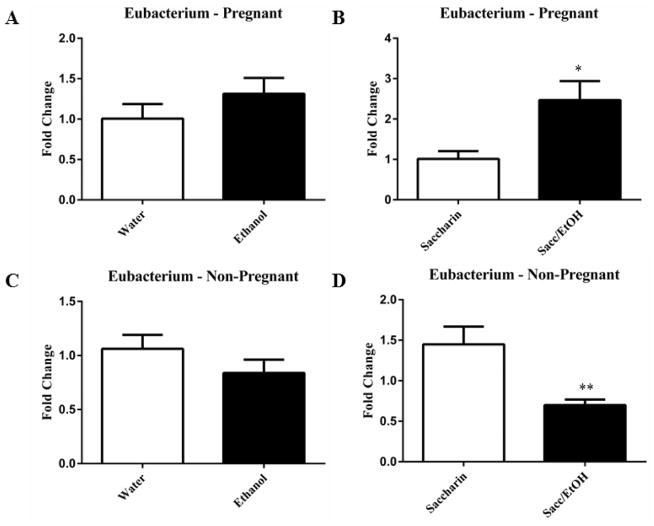
Drinking ethanol and saccharin together elevated levels of Eubacterium in pregnant mice but decreased it in non-pregnant miceEthanol in water solutions did not affect the levels of Eubacterium in either pregnant (2A) or non-pregnant animals (2C). Ethanol and saccharin in water solutions significantly increased Eubacterium levels in pregnant animals (2B) and significantly decreased Eubacterium levels in non-pregnant (2D) animals. Data are expressed as mean fold change ± SEM, n=8–10 mice, t (13) =2.87, *p=0.01(2B) and t (14) =3.23, **p=0.006 (2D). Ethanol drinking conditions are presented in the filled columns and control (water or saccharin alone) are in the unfilled columns.